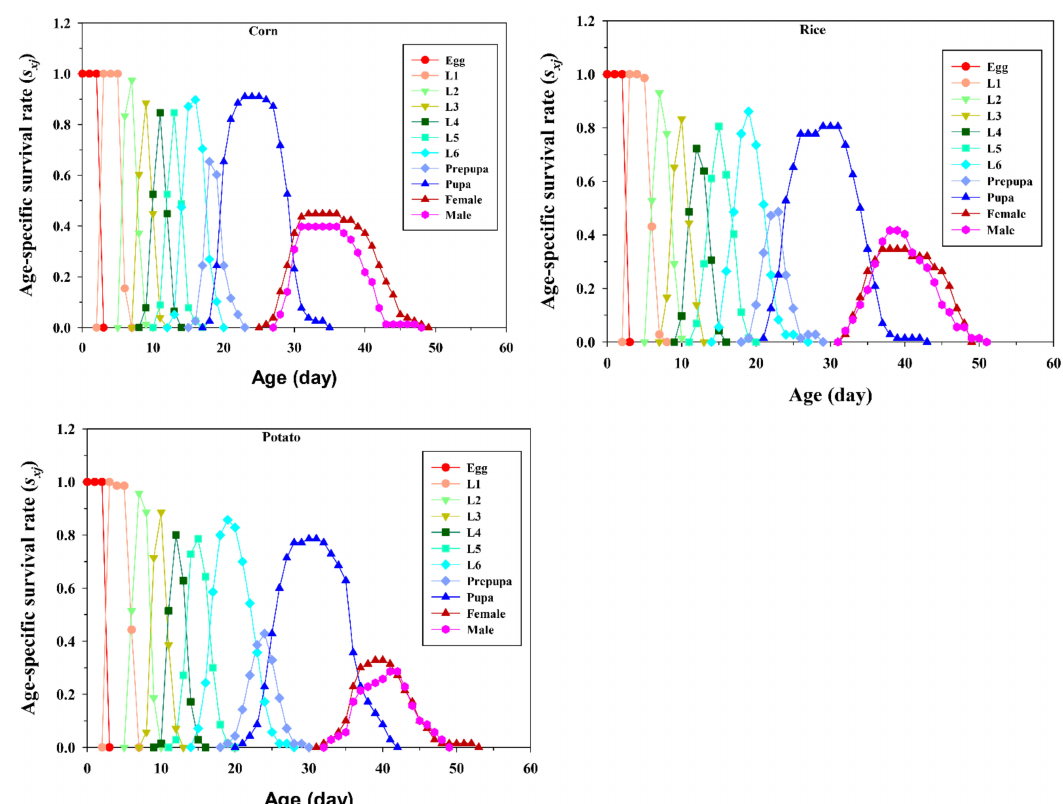
Figure 2. Age-stage-specific survival rate ( s xj ) of Spodoptera frugiperda fed on corn, rice, and potato. Curves of s xj depict the probability that a newborn will survive to age x and stage j (where L1–L6 are the larval instars from first to sixth). The various developmental rates among individuals overlap between different stages at the time of developmental